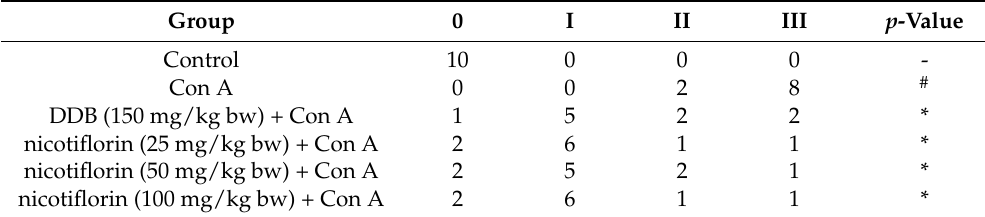
n = 10; # p < 0.01 compared with control group; * p < 0.05, compared with Con A group.